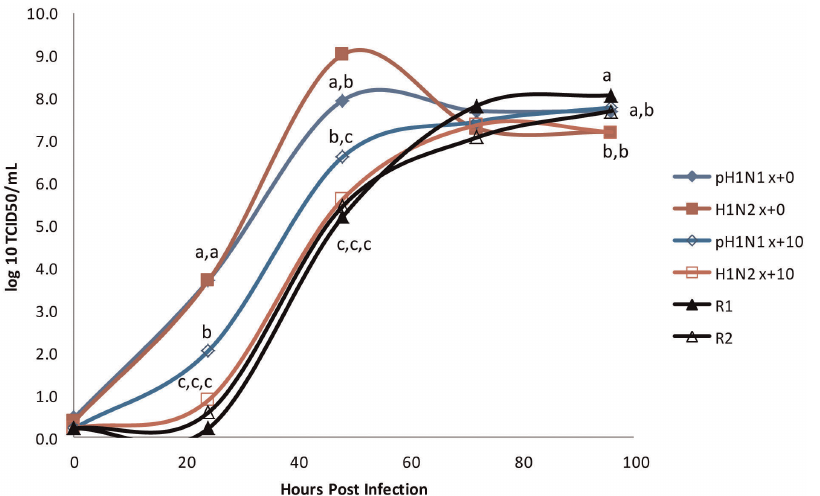
Figure 3. Multicycle growth curves for pH1N1 and H1N2, both before (x + 0) and after 10 passes (x + 10) in A549 cells, as well as reassortant viruses R1 and R2. Data represent means of triplicate growth curves.